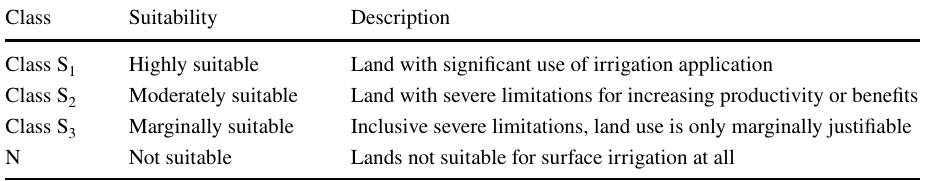
Table 1 Land suitability classes